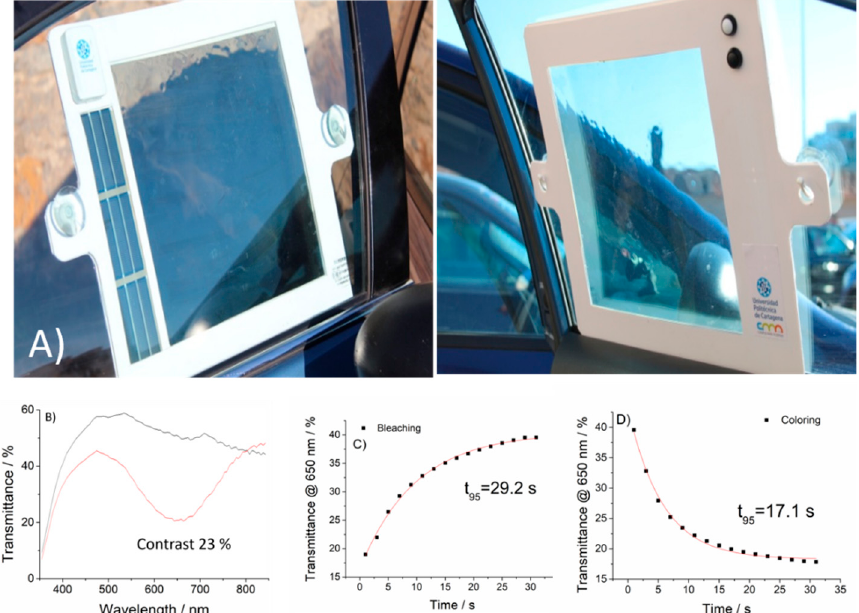
Figure 10. ( A ) Final prototype of a portable, self-powered flexible electrochromic “curtain” for automotive use. Active coloring area of 900 cm 2 , full-device area 1200 cm 2 . ( B ) Transmittance spectra in the colored and bleached states ( C , D ) Kinetics for bleaching and coloring processes.